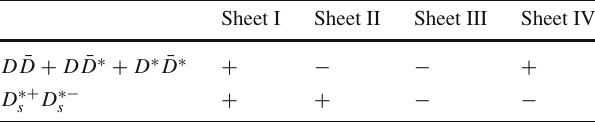
Table 3 Definition of the four Riemann sheets with D ∗+ s D ∗− s channel and the D ¯ D , D ¯ D ∗ and D ∗ ¯ D ∗ channels as a whole